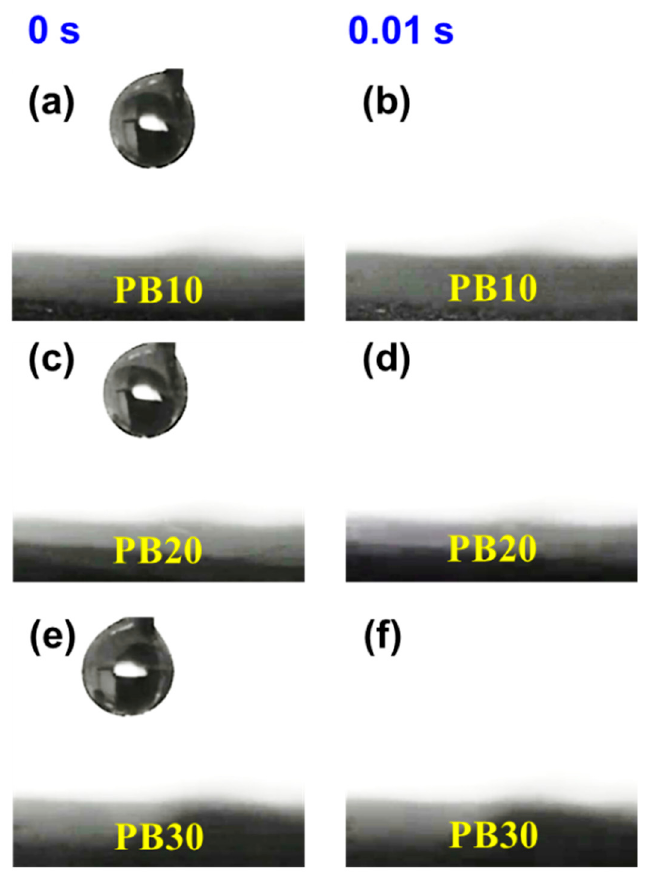
Figure 10. Initial images of ( a ) PB10 ( c ) PB20 ( e ) PB30 and dynamic contact angle images of the time required for the complete wetting of water droplets on various polymer/BiOBr-coated gauze ( b ) PB10